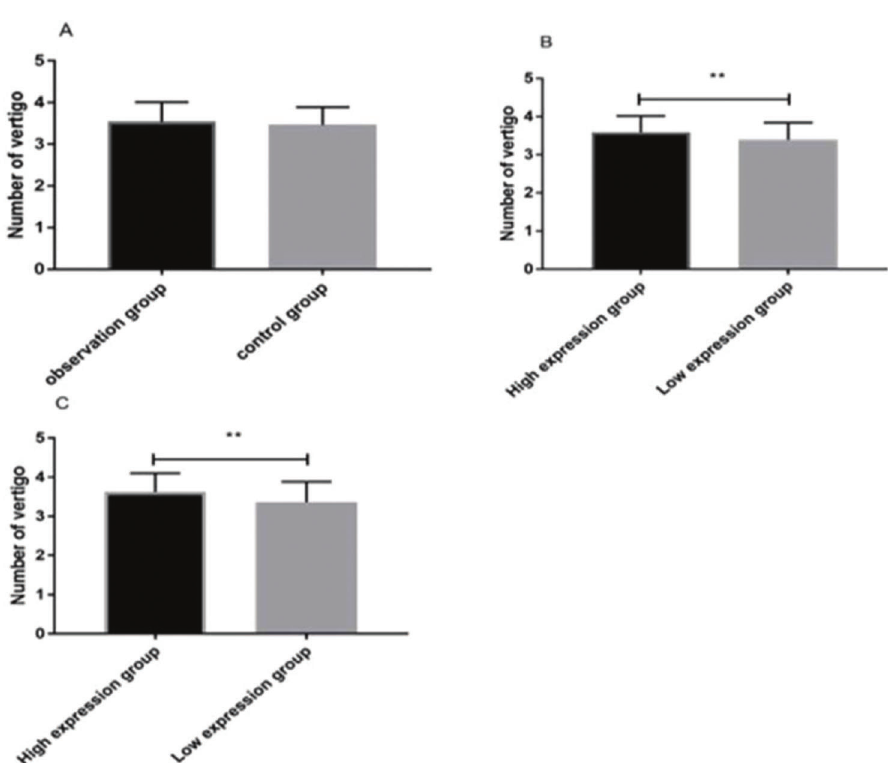
Figure 3 - Vertigo attacks 6 months after treatment. There was no statistically significant difference in the number of vertigo attacks 6 months after treatment between the observation and control groups (t=1.036, p =0.302) (A). Attacks in the IgG high-expression group were significantly more frequent than those in the IgG low-expression group (t=2.650, p =0.009) (B). Attacks in the IgM high-expression group were significantly more frequent than those in the IgM low-expression group (t=3.030, p =0.003) (C). Note: ** indicates p o 0.01.